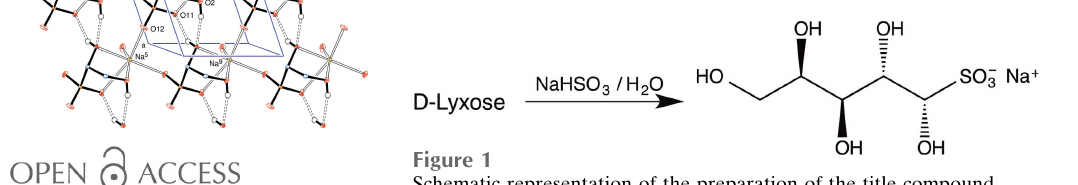
Figure 1 Schematic representation of the preparation of the title